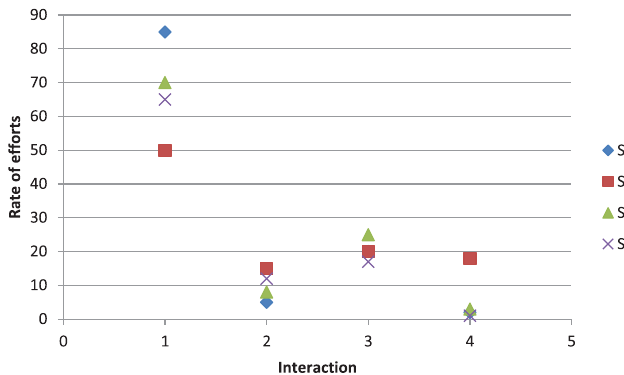
Fig. 8. A graphical representation of the optimal efforts distribution.